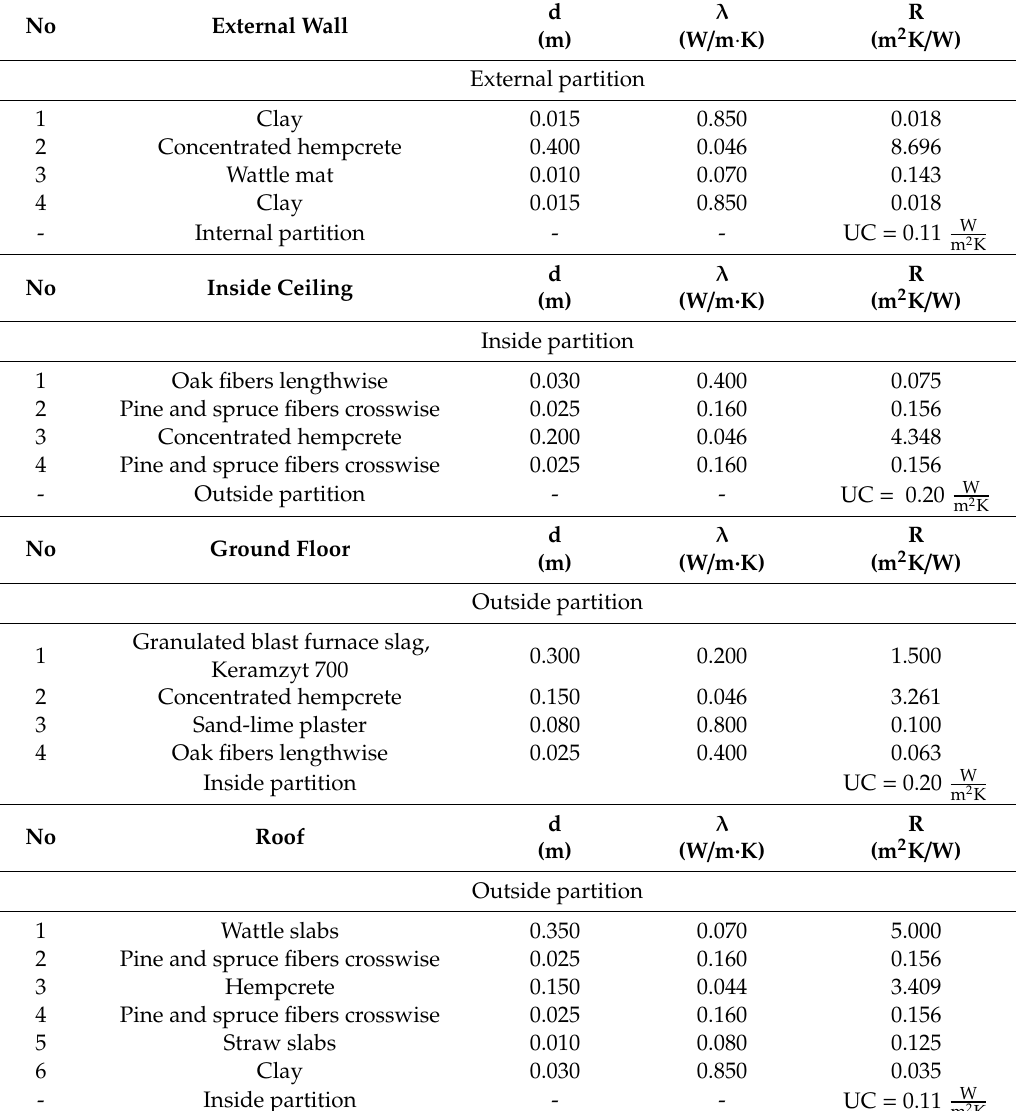
Table 7. The main partition structure of a hemp–lime composite